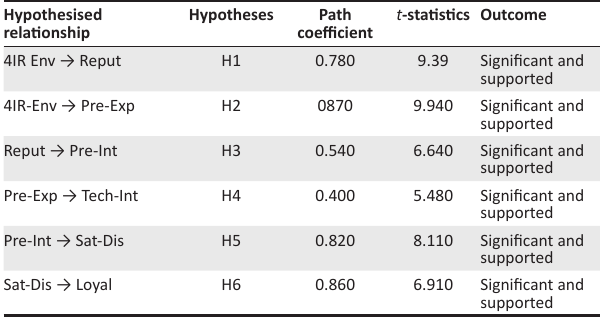
TABLE 5: Goodness of fit table. Model fit indices